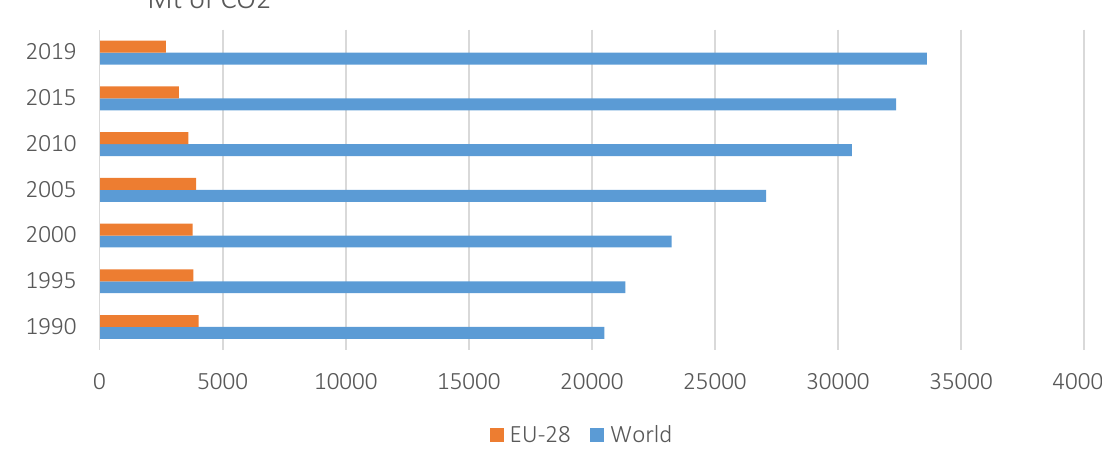
Figure 8. Total CO2 emissions,